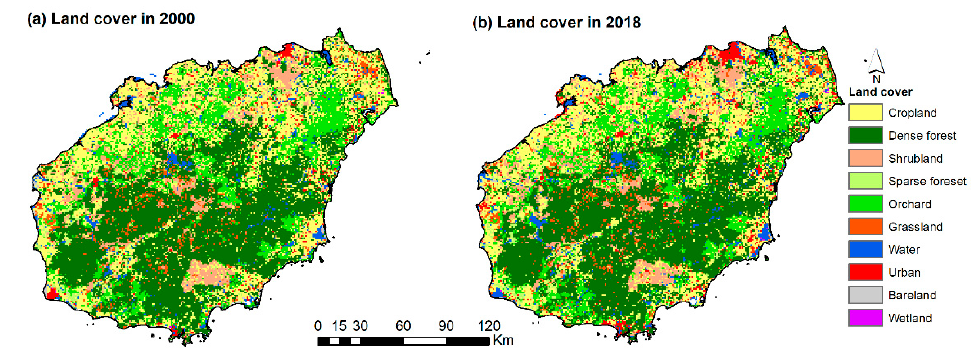
Figure 11. The land cover comparison in 2000 and 2018.